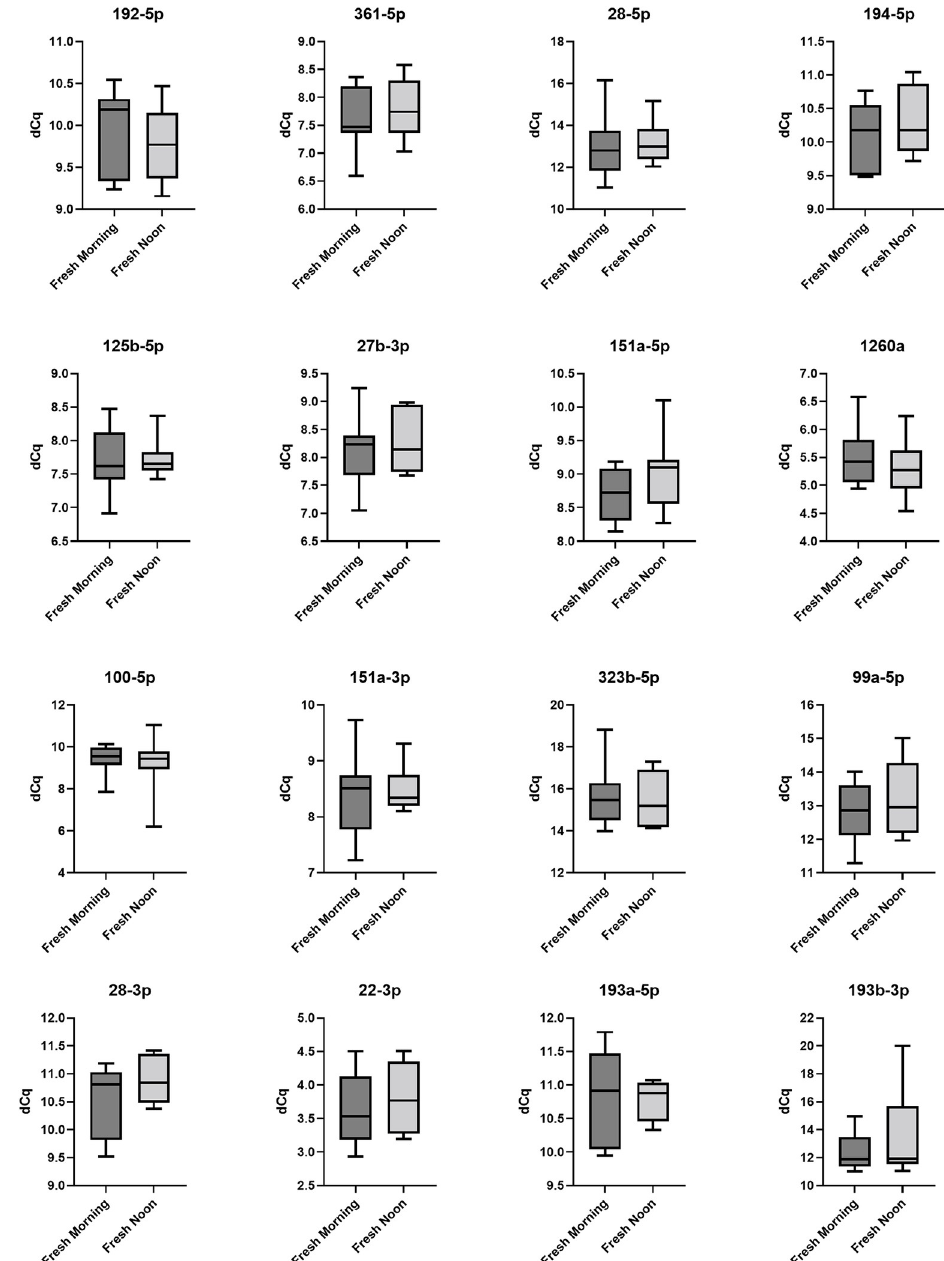
Fig 1. Fresh morning versus fresh noon. Box plots of dCq values of serum MiRNA samples (n = 8) taken in the morning under fasting condition compared to samples (n = 8) taken at noon after normal eating and drinking. All samples were analyzed within 24 hours. The differences in the expression were not